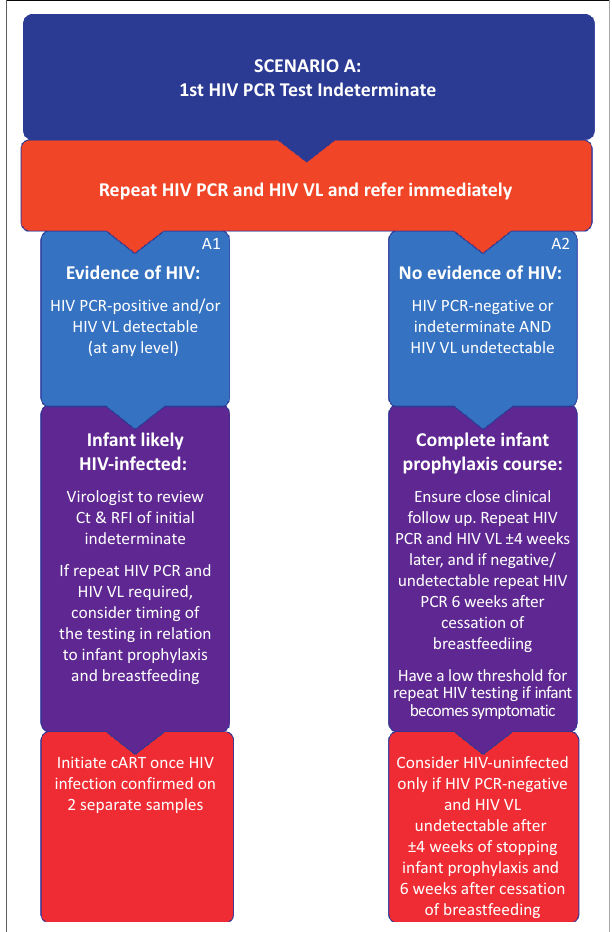
(Figure 1: A2). As antiretroviral therapy (ART) may